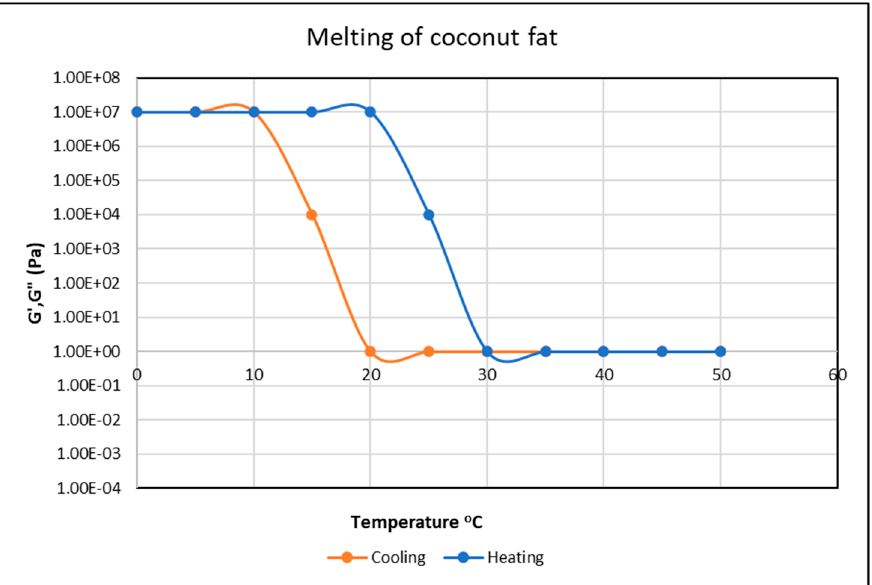
Figure 8. Representative melting and crystallization behavior of coconut fat with temperature.